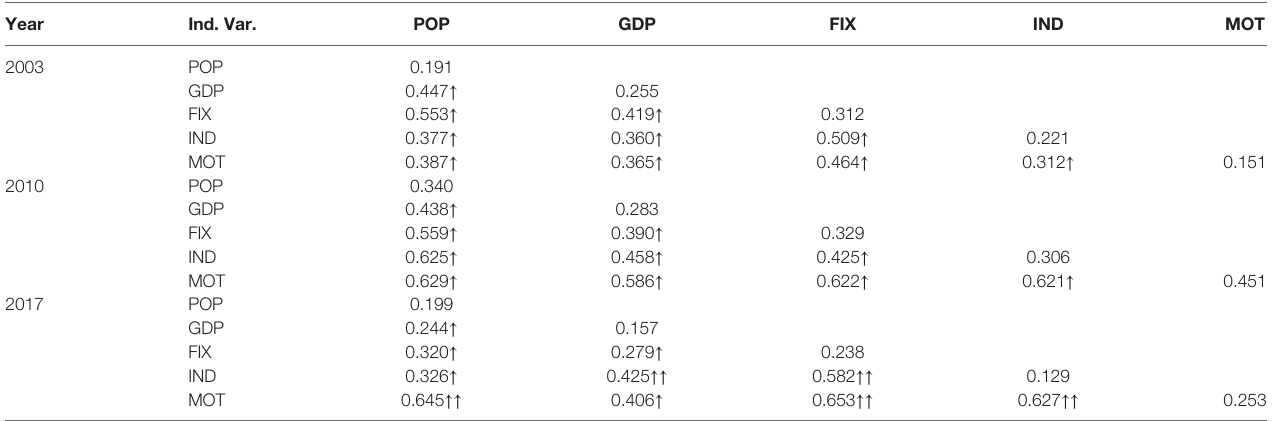
TABLE 4 | Results of the interaction detection analysis.